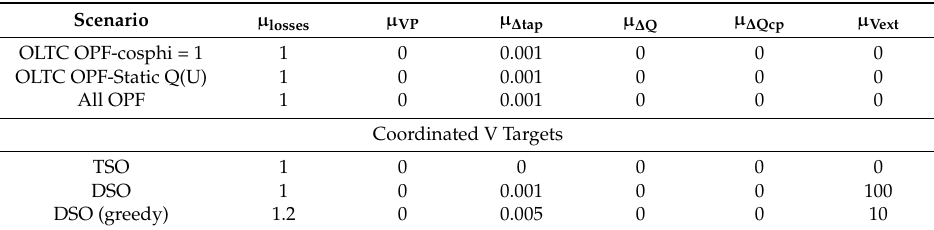
Table 5. OF weights for performance